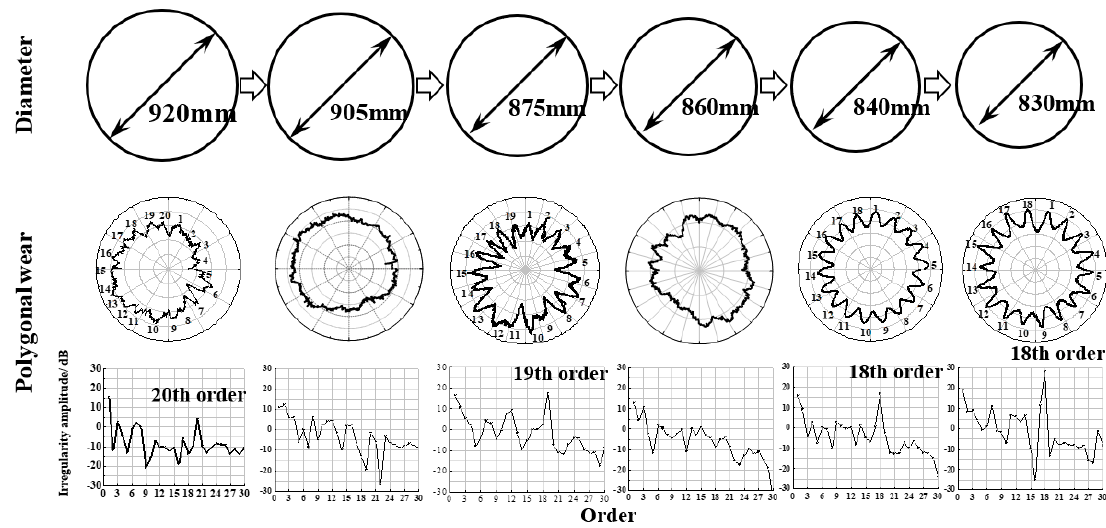
Figure 6. Decrease in order with a decrease in wheel diameter.